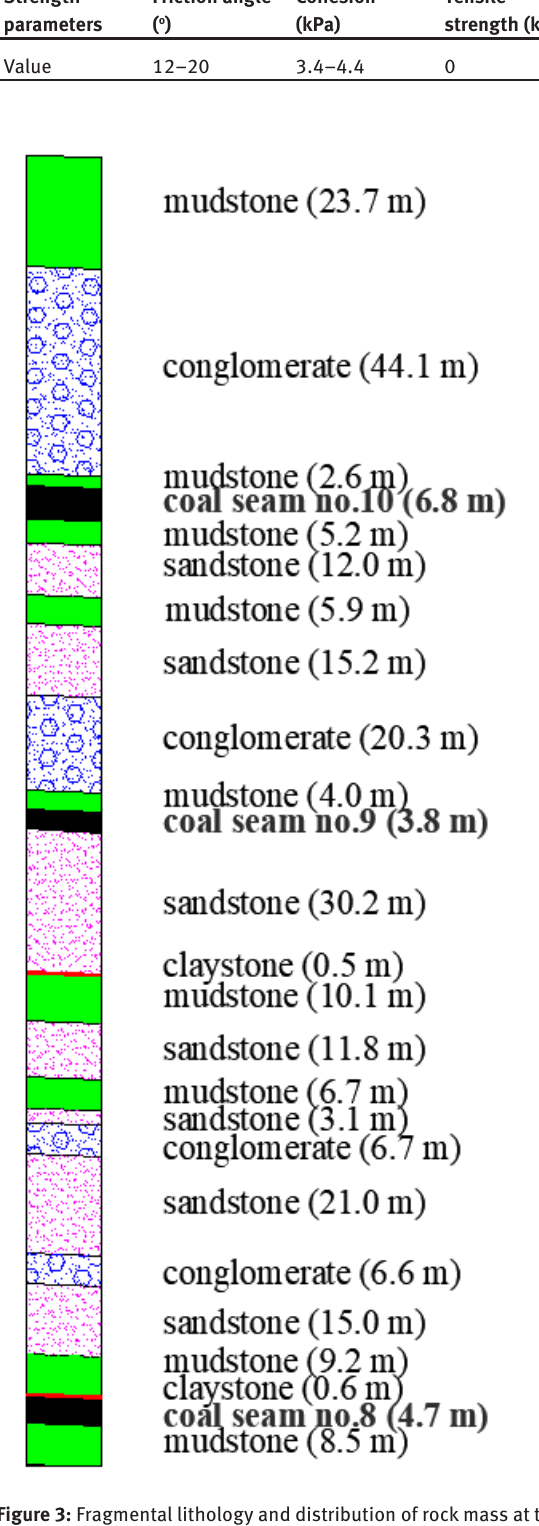
Figure 3: Fragmental lithology and distribution of rock mass at the site